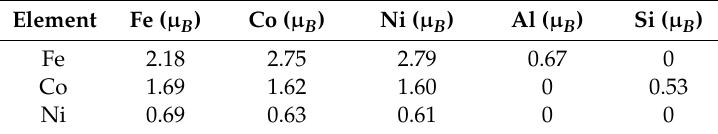
Table 4. The calculated magnetic moments of Fe, Co and Ni in binary FeM-, CoM- and NiM-ordered alloys.